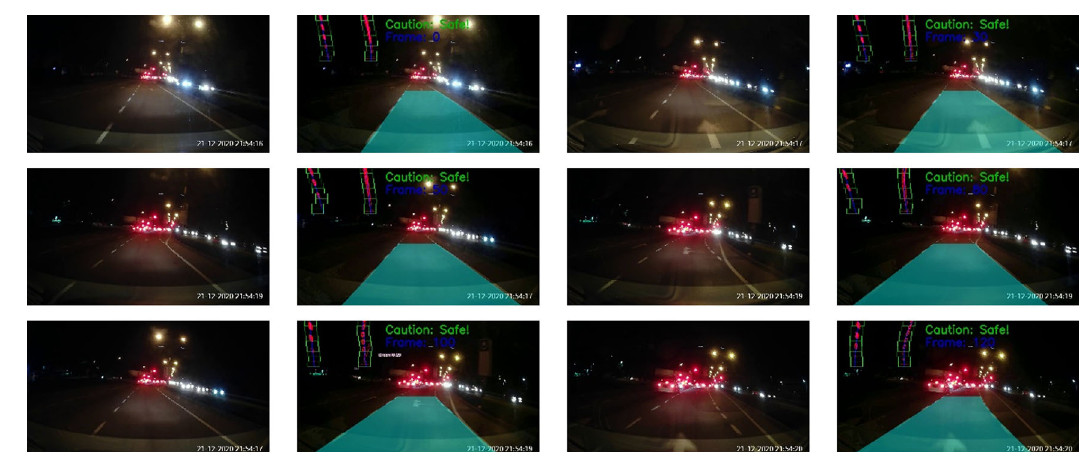
Figure 16. Normal road in the